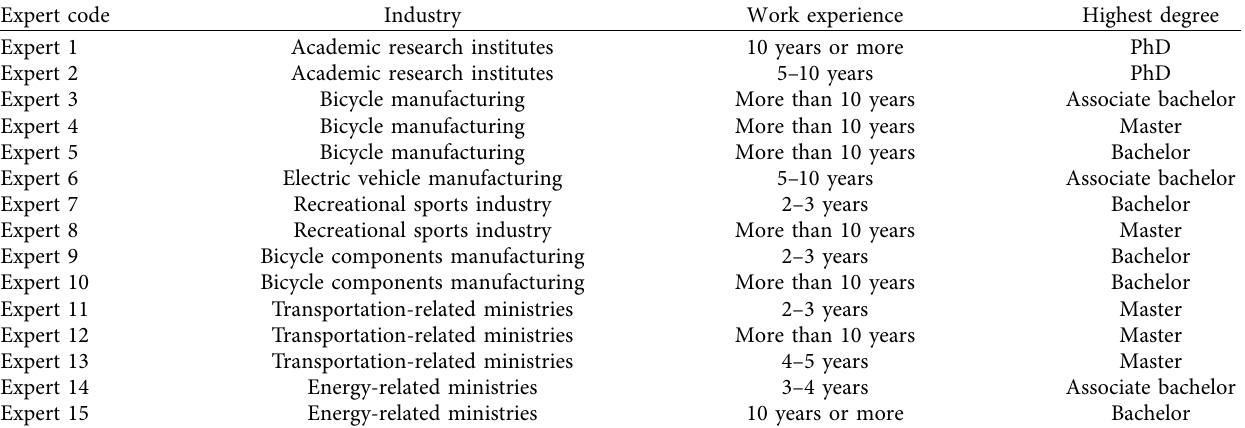
Table 2: Background introduction of 15